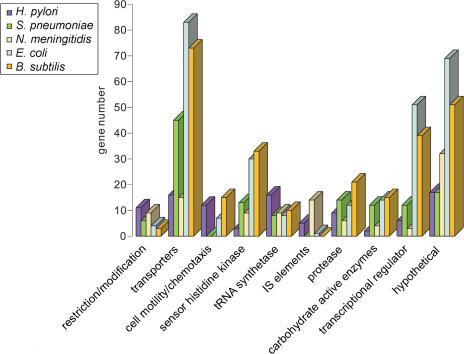
Abundance of SVGs in Different Functional Categories in Five MicroorganismsThe approximate total gene number for each organism is as follows: H. pylori, 1,566 genes; S. pneumoniae, 2,094 genes; N. meningitidis, 2,065 genes; E. coli, 4,289 genes; B. subtilis, 4,100 genes.